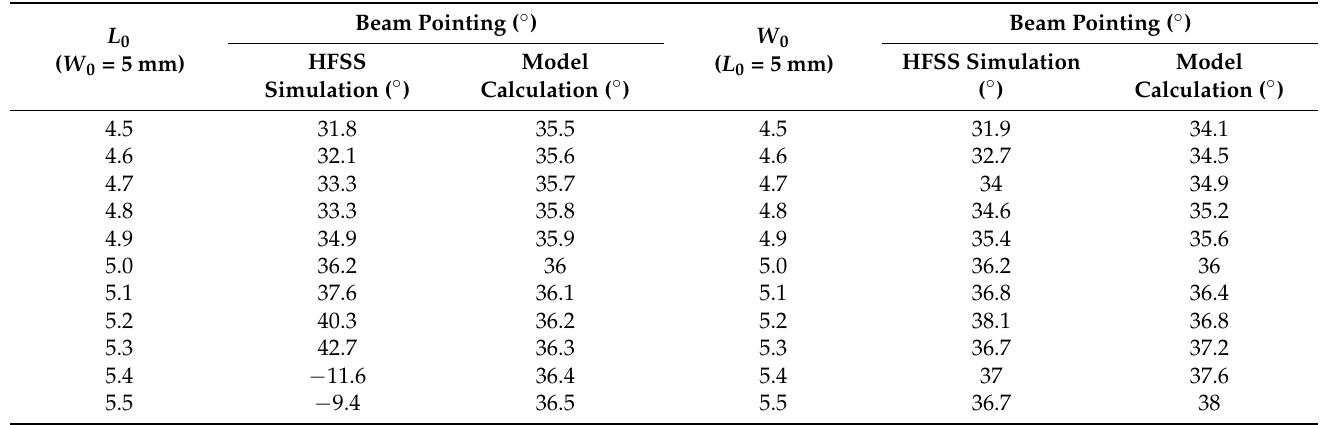
Table 8. HFSS simulation results and coupling model calculation results of different W 0 and L 0 parameters under Mode 3 antenna.